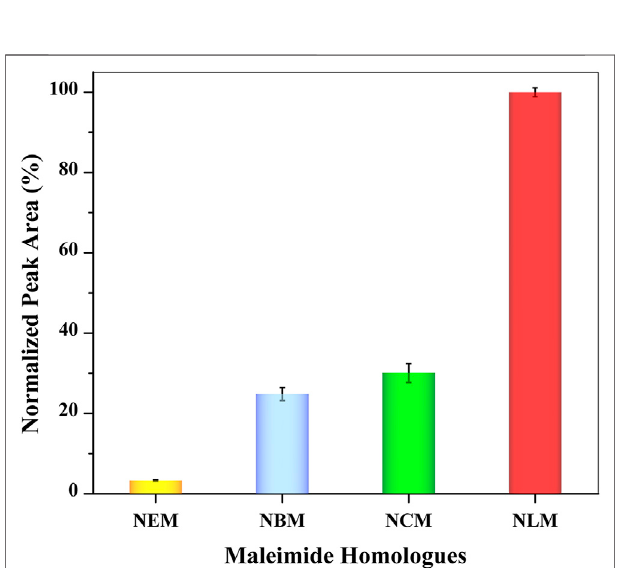
FIGURE 2 | Effect of maleimide homologues types on extraction ef fi ciency ( n (cid:2) 3).